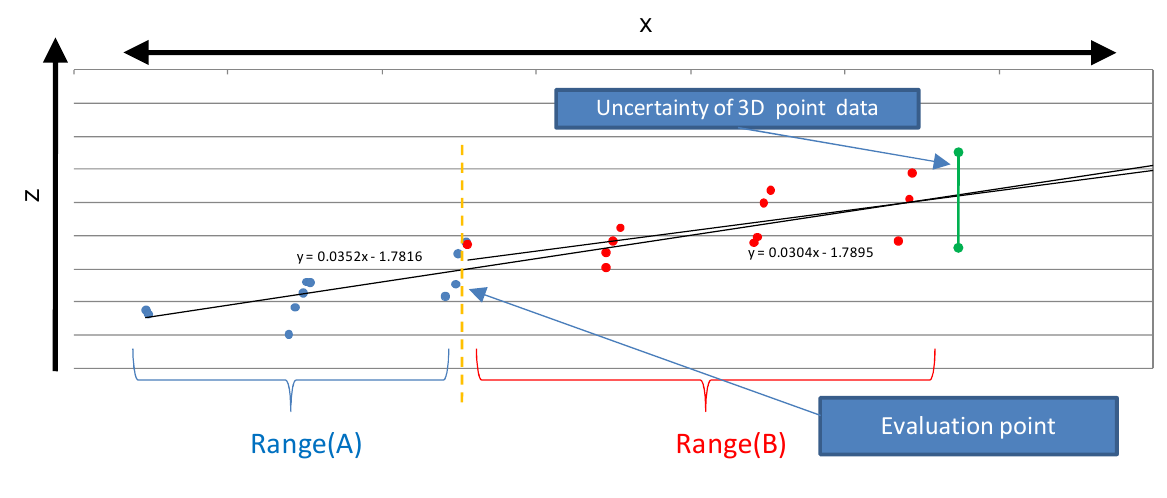
Figure 2. Basic idea of